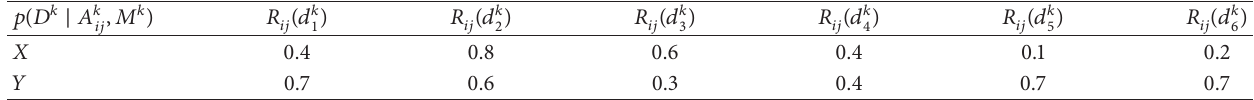
Table 2: The probabilities of hazard losses.